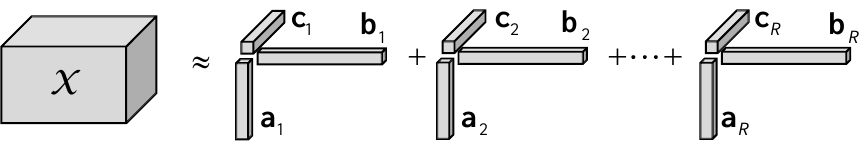
Figure 2. Canonical polyadic (CP) decomposition of third-order tensors